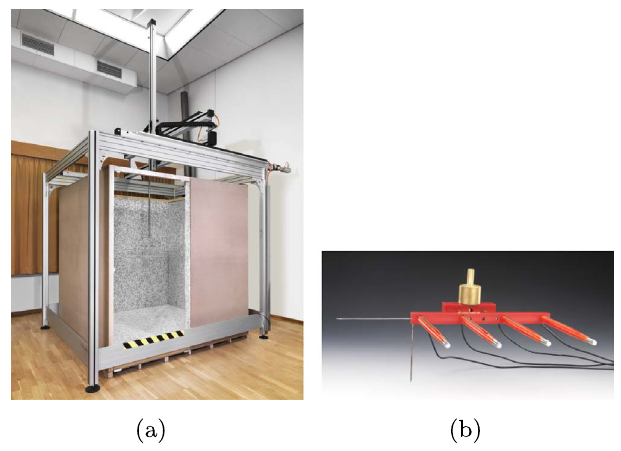
Figure 1. Components of the measuring system. (a) Scanning unit of the measuring system with an integrated free- fi eld environment. (b) Microphone array with four 1/4 00 microphones and two mechanical probes for tactile coordinate